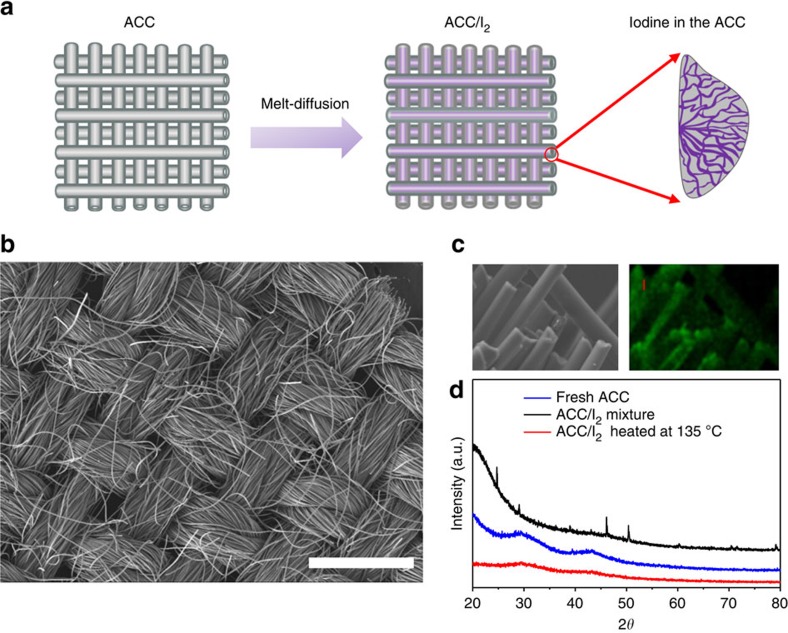
Material characterization of the active carbon cloth/iodine cathode.(a) Procedure for preparing the ACC/I2 electrode. (b) Scanning electron microscopy images of the ACC/I2 cathode, scale bar: 1 mm. (c) Energy-dispersive spectroscopy mapping of I in the ACC/I2 cathode. (d) X-ray diffraction pattern of the ACC/I2 cathode.